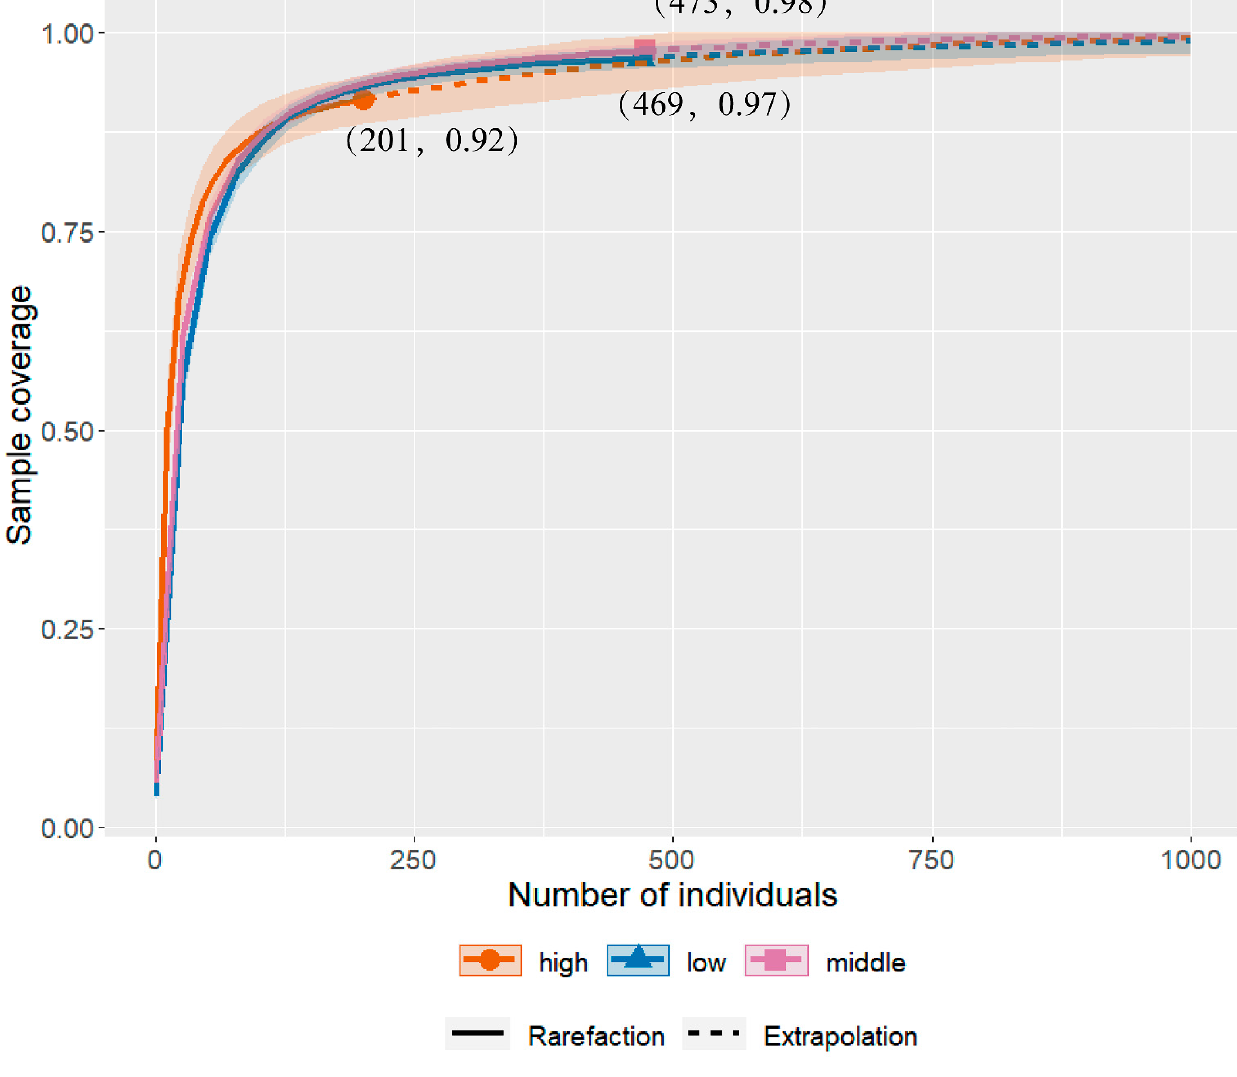
Figure 2. Sample completeness curve of Pyraustinae and Spilomelinae among different